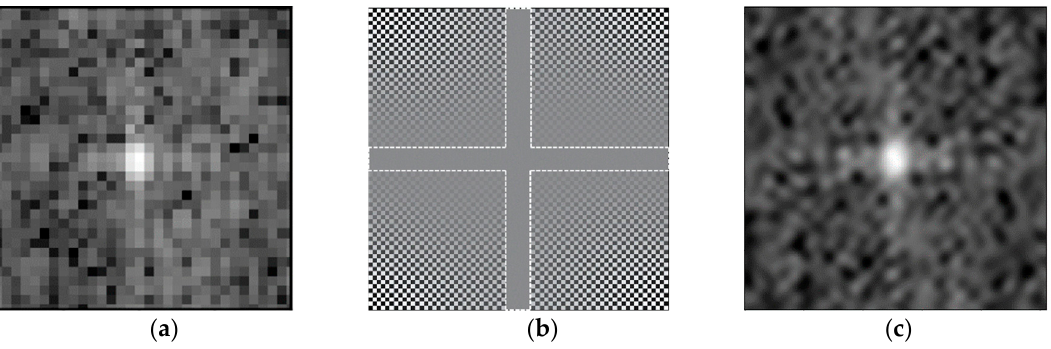
Figure 3. Schematic diagram of FFT interpolation. ( a ) Point target before interpolation. ( b ) Frequency graph after zero padding. ( c ) Point target after interpolation.